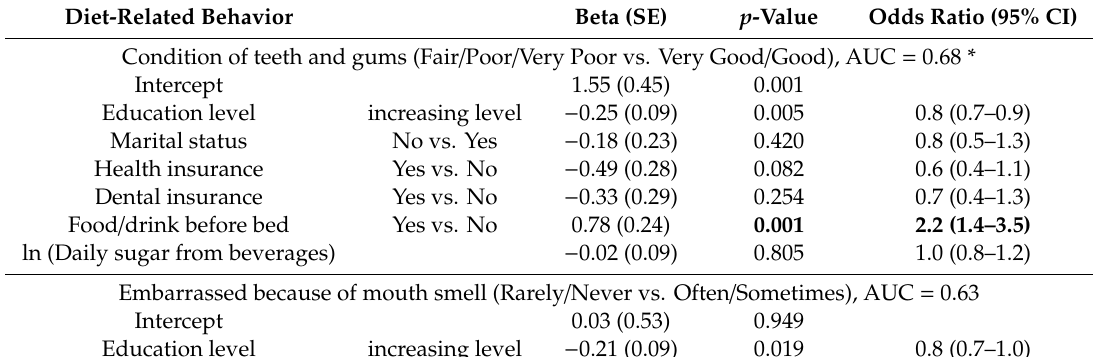
Table 4. Multivariable analyses dental outcomes based on demographic characteristics and diet-related